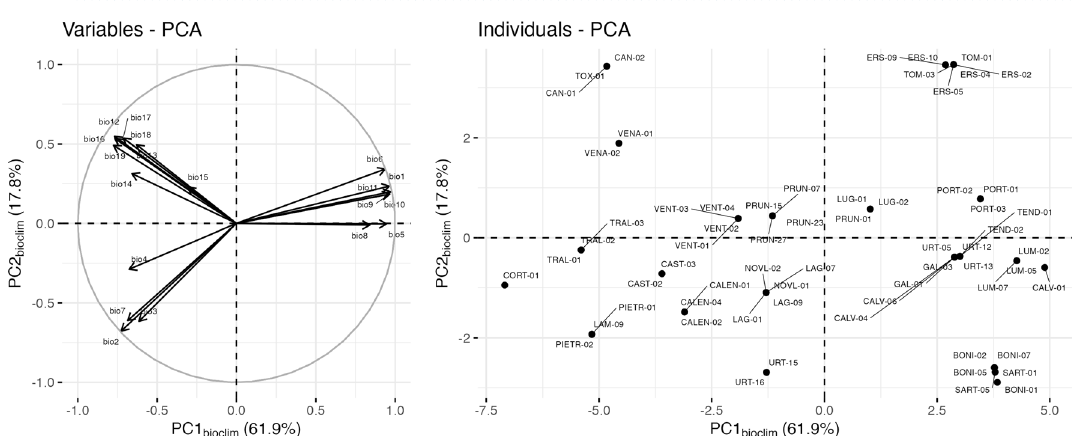
Figure 4. Principal component analysis of the 19 bioclimatic variables computed over the 2018–2020 period. ( A ) Correlation circle. Variable abbreviations are as follows: bio1 = annual mean temperature, bio2 = mean diurnal range, bio3 = isothermality (bio2/bio7) (× 100), bio4 = temperature seasonality, bio5 = maximum temperature of warmest month, bio6 = minimum temperature of coldest month, bio7 = temperature annual range (bio5-bio6), bio8 = mean temperature of wettest quarter, bio9 = mean temperature of driest quarter, bio10 = mean temperature of warmest quarter, bio11 = mean temperature of coldest quarter, bio12 = annual precipitation, bio13 = precipitation of wettest month, bio14 = precipitation of driest month, bio15 = precipitation seasonality (coefficient of variation), bio16 = precipitation of wettest quarter, bio17 = precipitation of driest quarter, bio18 = precipitation of warmest quarter, bio19 = precipitation of coldest quarter. ( B ) Projection of sampling plots on the first factorial plan. Raw data are provided in Table